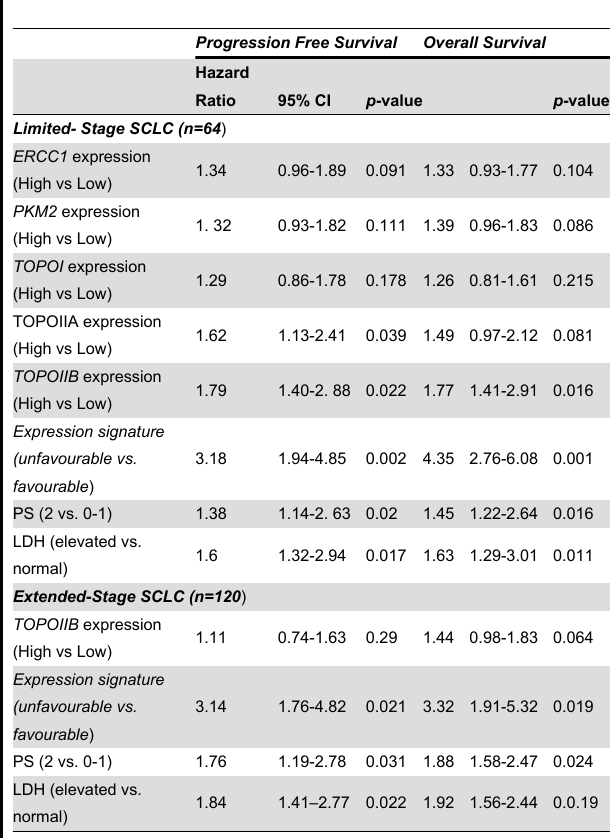
Table 4. Multivariate analysis for Progression Free Survival and Overall